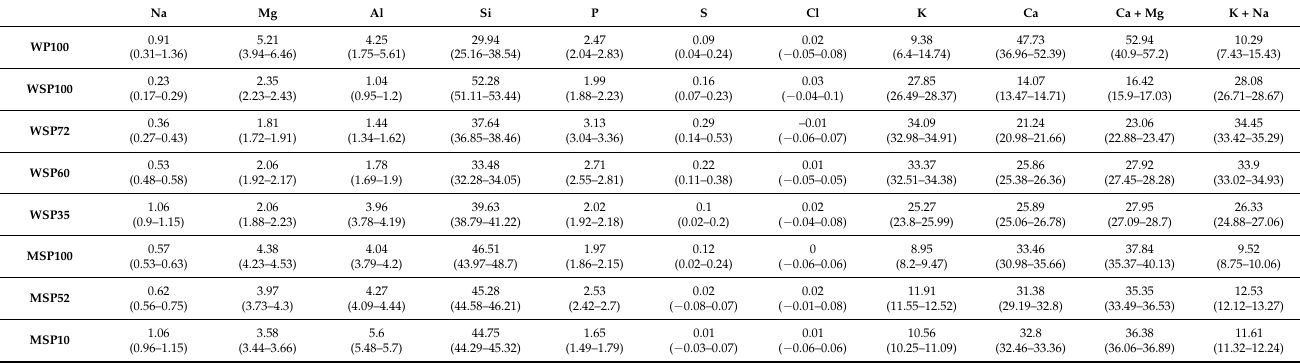
Table 4. Mean values (range) of the elemental composition (SEM-EDS) of fraction S2/3 of bottom ash, expressed as a percentage of the total mass of measured elements (Na, Mg, Al, Si, P, S, Cl, K and Ca) (%m/m: mass